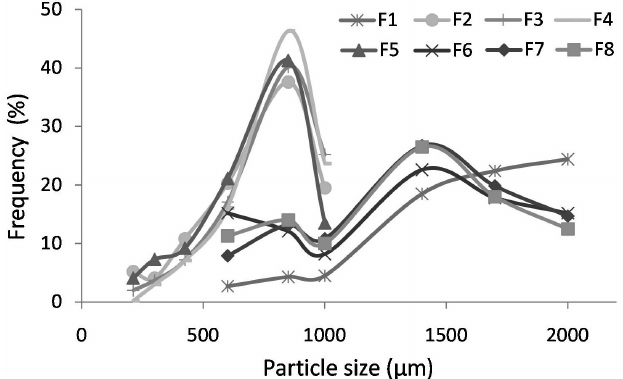
FIGURE 1 - Particle size distribution of Maytenus ilicifolia formulations of effervescent granules (F1, F2, F3, F4, F5, F6, F7 and F8) obtained from the factorial design using sonic